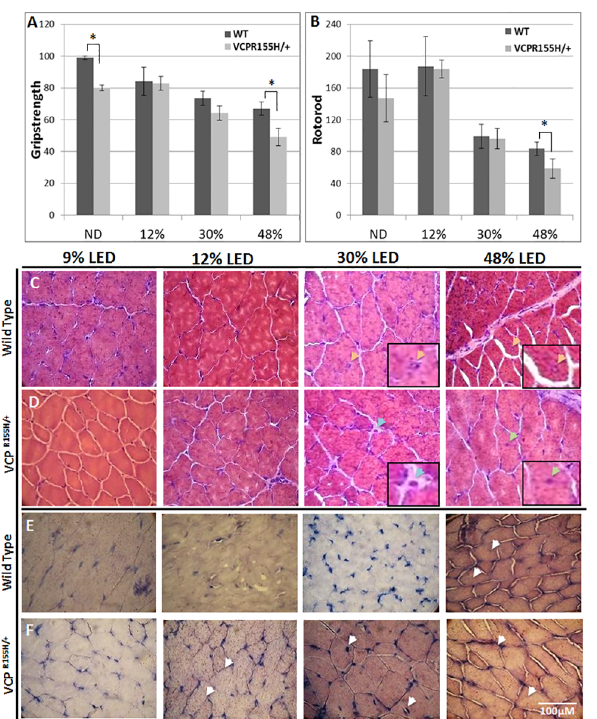
Fig 3. Strength measurements and histological stainings of quadriceps muscle of WT and VCP R155H/+ mice on normal and different lipid-enriched diets. (A,B) Grip strength and Rotarod measurements analyses at 15-months of age, (C,D) H&E and (E,F) Oil Red O staining of quadriceps muscle from WT and VCP R155H/+ animals placed on the 9%, 12%, 30%, and 48% LED from birth. The number of mice analyzed per experiment is 8 – 10. Insets show magnified pathology, including rimmed vacuoles (orange arrows), atrophy (blue arrows), centralized nuclei (green arrows), and increased lipid droplets (white arrows).